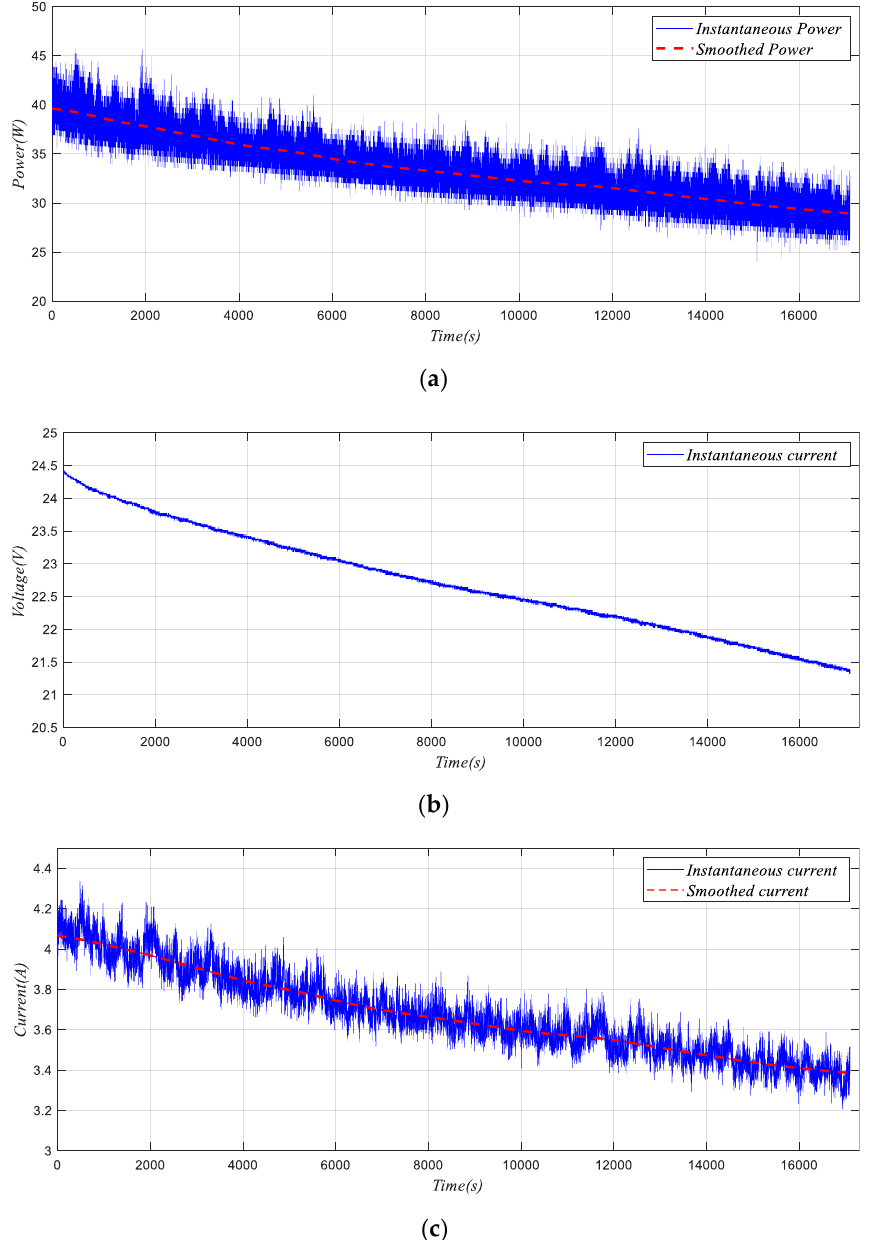
Figure 4. Test result of low-temperature discharge test at − 25 degrees Celsius, 540 hPa: ( a ) Power, ( b ) voltage, ( c ) current.